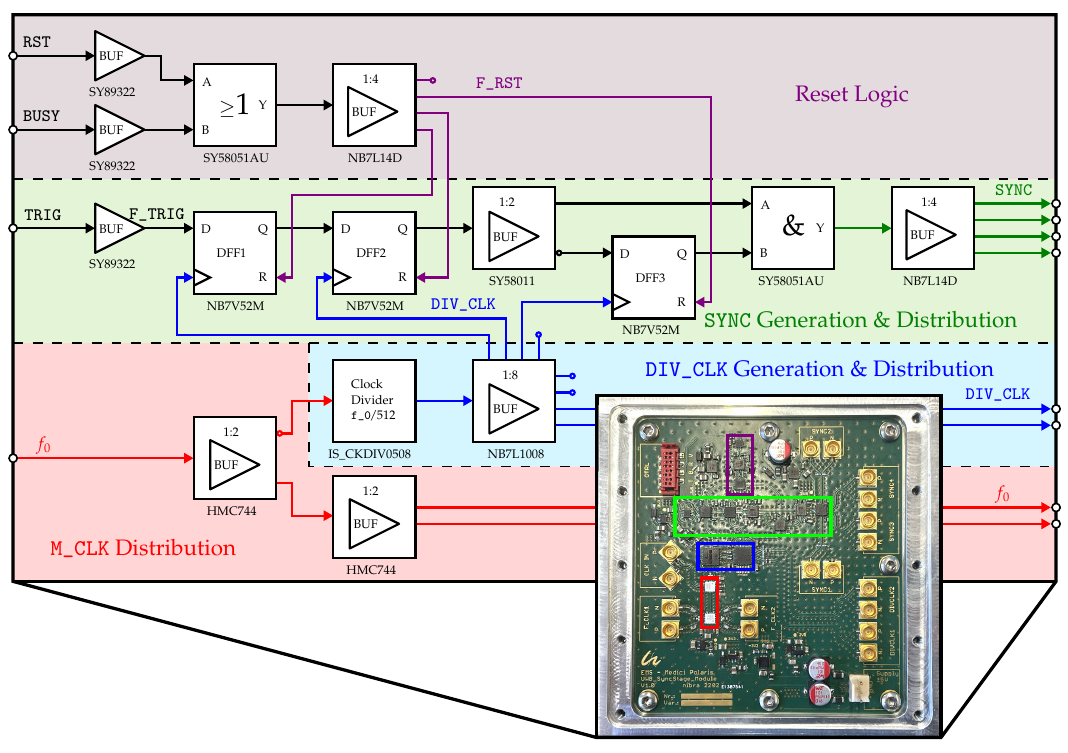
Figure 8. Circuit block design of the synchronization unit. Circuit functions are grouped by